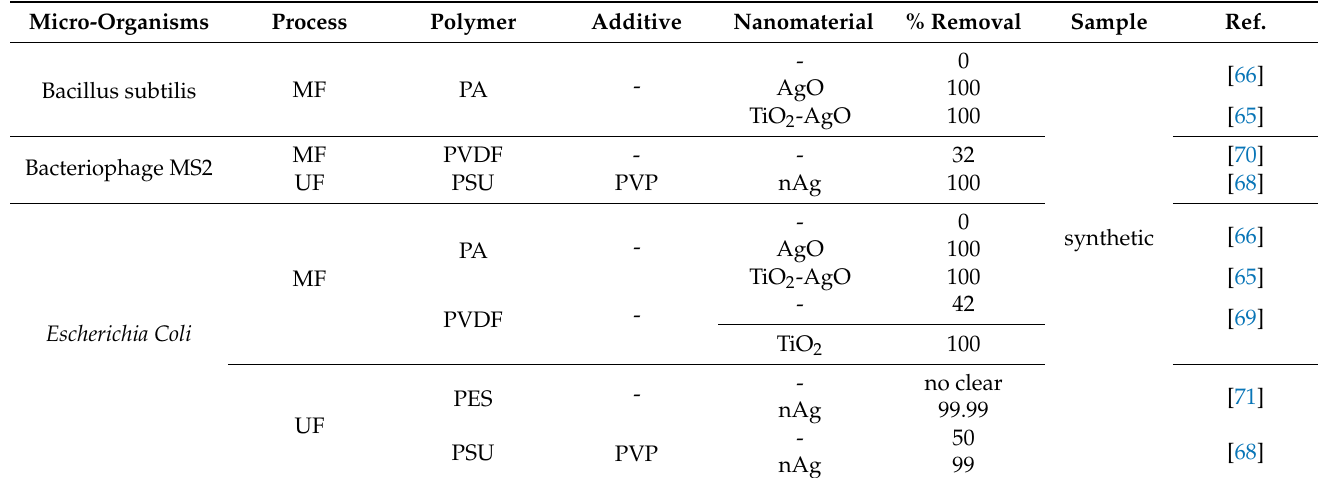
Table 3. Application of polymeric membranes in the purification of water contaminated with